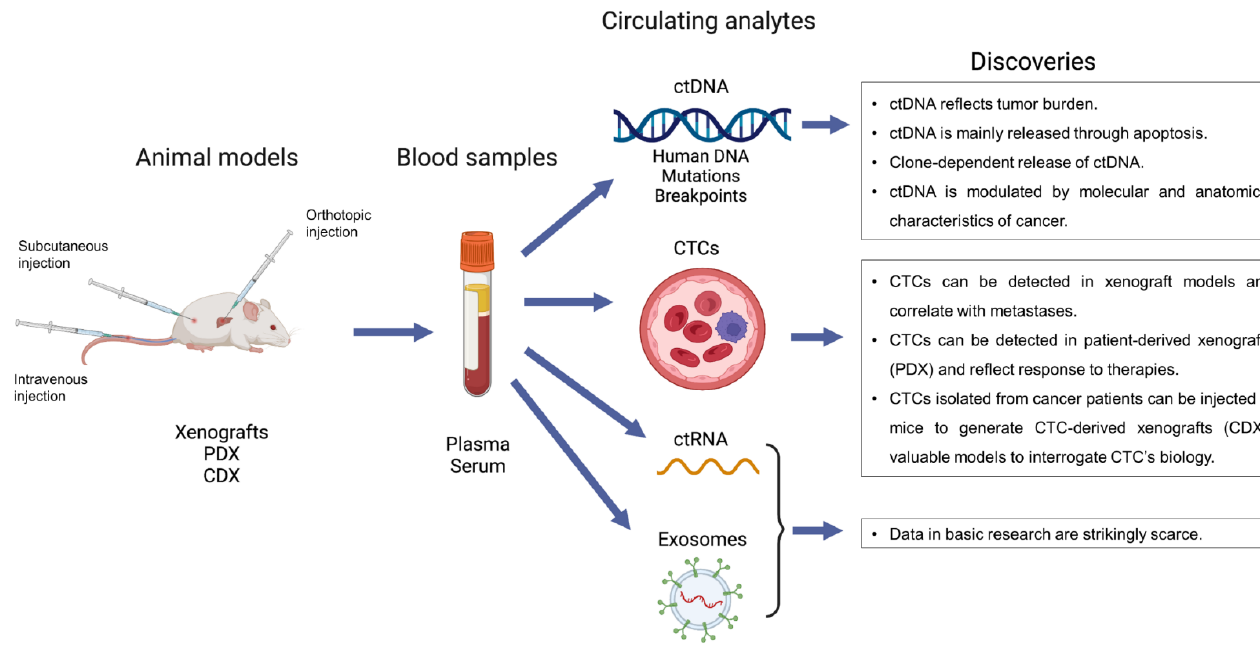
Figure 1. Schematic summary of the available studies on liquid biopsy in basic research with their main findings.